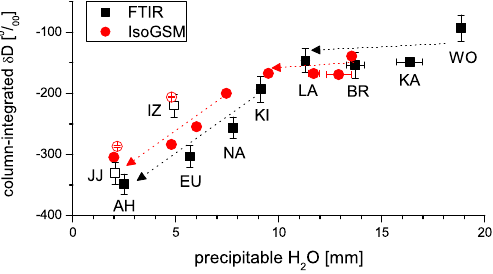
Fig. 14. Plot of multi-year mean column-integrated δ D versus multi-year mean total precipitable water vapour. Station acronyms are given at each data point. Black squares: FTIR data; Red dots IsoGSM simulations. The dashed black and red arrows indicate the typical δ D-H 2 O distribution of the FTIR and IsoGSM data, respec- tively. The values from high-altitude stations are distinguished by open symbols.